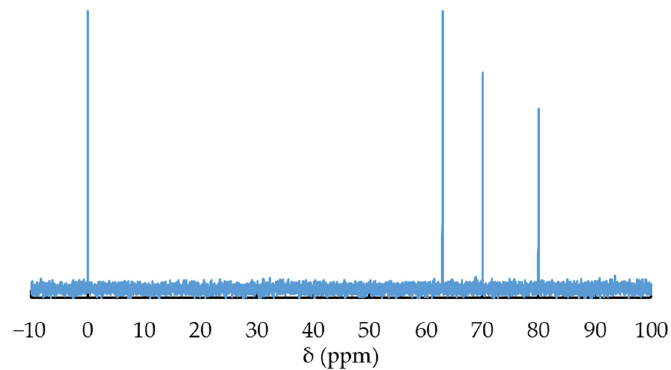
Figure 4. 27 Al NMR spectra of PAC30.